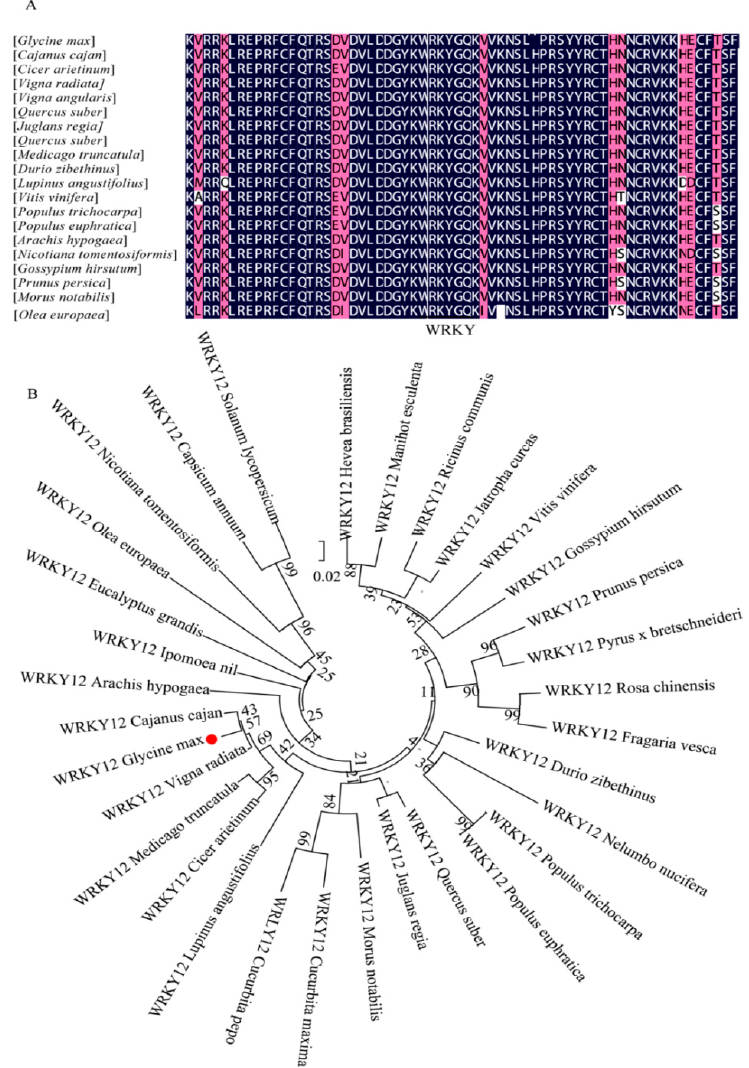
Figure 4. Multiple alignment and phylogenetic relationship of GmWRKY12 with different species. ( A ) Multiple alignment of GmWRKY12 with other WRKY12 proteins from other species. ( B ) Phylogenetic relationship of GmWRKY12 in different species. The red dot in ( B ) means GmWRKY12. The number of nodes is the bootstrap value and the number on the branch is the evolutionary distance. Bootstrap replications are 1000.